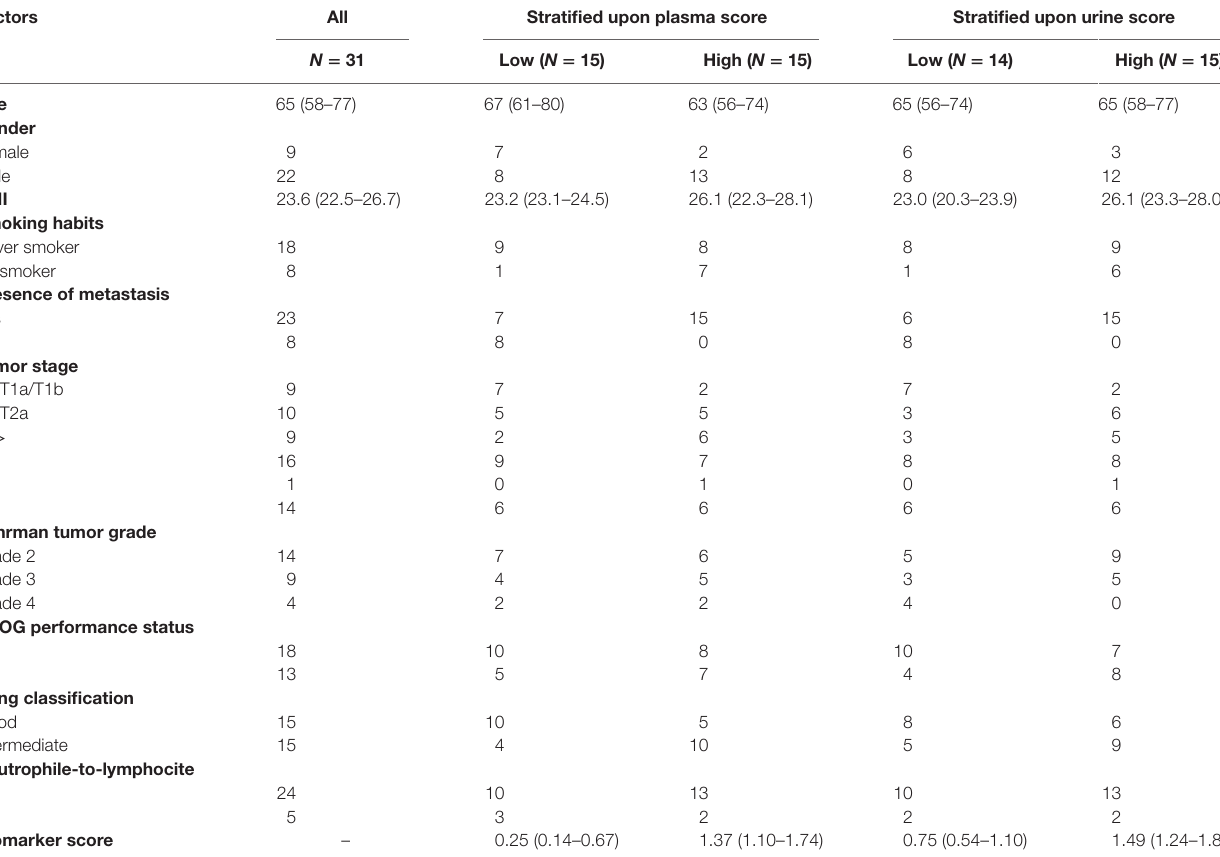
Distributions are summarized as median and interquartile ranges in brackets.